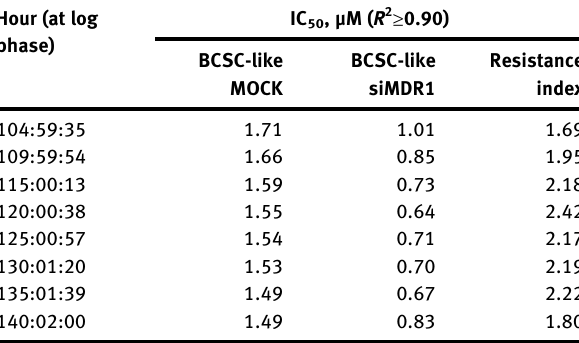
Table  : IC  values (time dependent manner), *Resistance index (RI) was calculated from the formula: resistance index = IC  mock control /IC  siMDR 